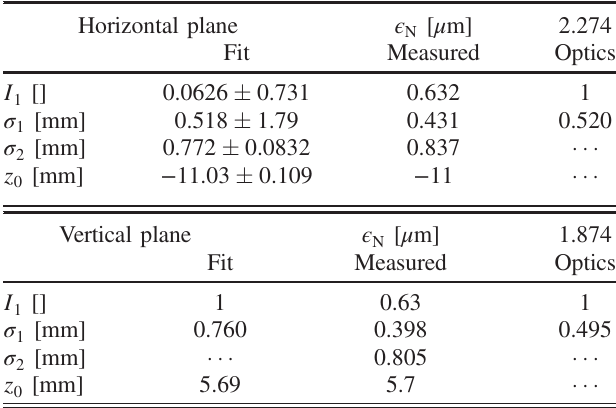
TABLE IV. Normalized emittances as from the WS measure- ments and parameters of the curves shown in Fig. 5: “ fit ” refers to the fit of Eq. (1) through the data (green curves in the referred figure), whereas “ measured ” refers to double Gaussian distribu- tions previously measured in SPS [16] and scaled with the emittance in machine (red curves in the referred figure). Errors of the fitting curves on the vertical plane are not reported since they are 0, because the number of fitting parameters is equal to the number of data points. Values of betatron σ at 450 GeV =c as from linear optics and normalized emittances available in machine are shown for